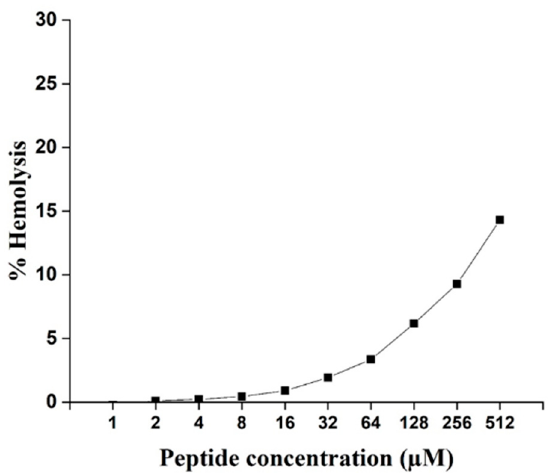
Figure 7. Hemolytic activity of the ZM-804 peptide. ZM-804 induced hemolysis (%) of mouse RBCs at different peptide concentrations and was defined as a ratio of complete hemolysis caused by 1% Triton X-100. Data are expressed as the means of measurement from three independent experiments.